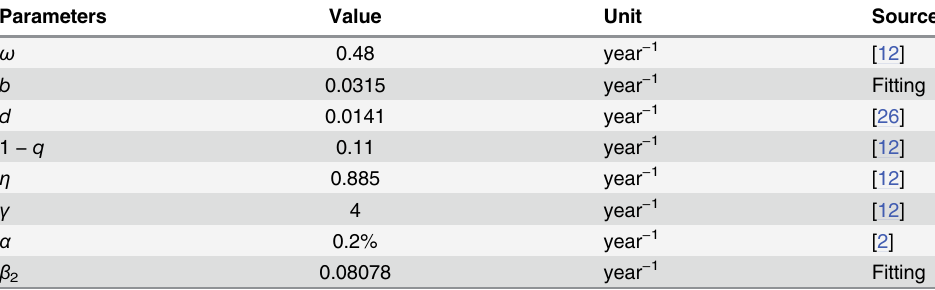
Table 2. Parameters and their